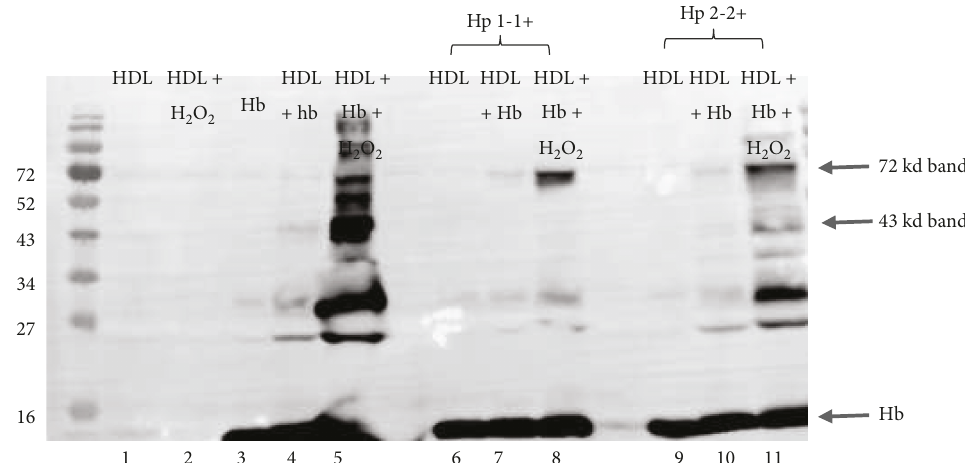
Figure 1: Detection of Hb cross-links on HDL by Western blot. Hp 1-1 or 2-2 was incubated with Hb (1 :1 ratio) creating a Hp-Hb complex. These complexes, with or without H and were transferred to a PVDF membrane. (1) HDL, (2) HDL+H (7) HDL+Hb/Hp 1-1, (8) HDL+Hb/Hp 1-1+ H